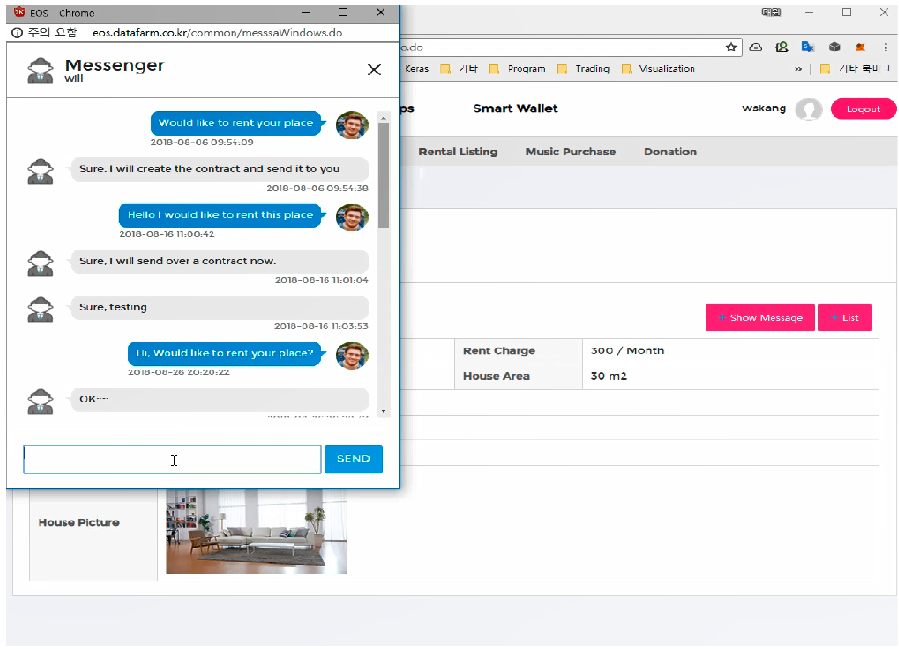
Figure 14. Chat screen between parties of the Blockchain contract in real estate transaction.